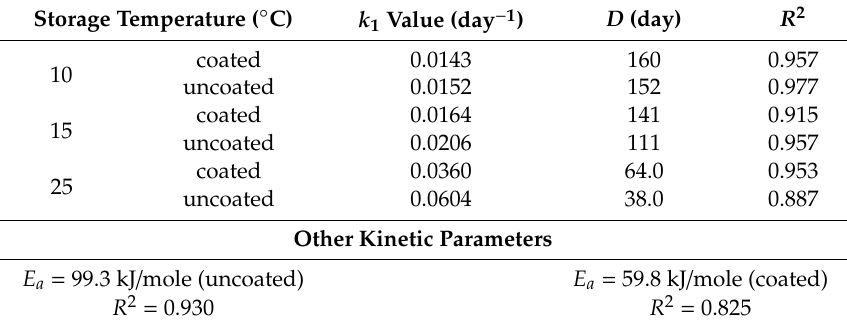
Figure 7. Changes in brix/acidity ratio of ( a ) uncoated and ( b ) coated limes during storage at different temperatures. Table 5. Kinetic parameters for brix/acidity changes of coated and uncoated limes stored at different temperatures.